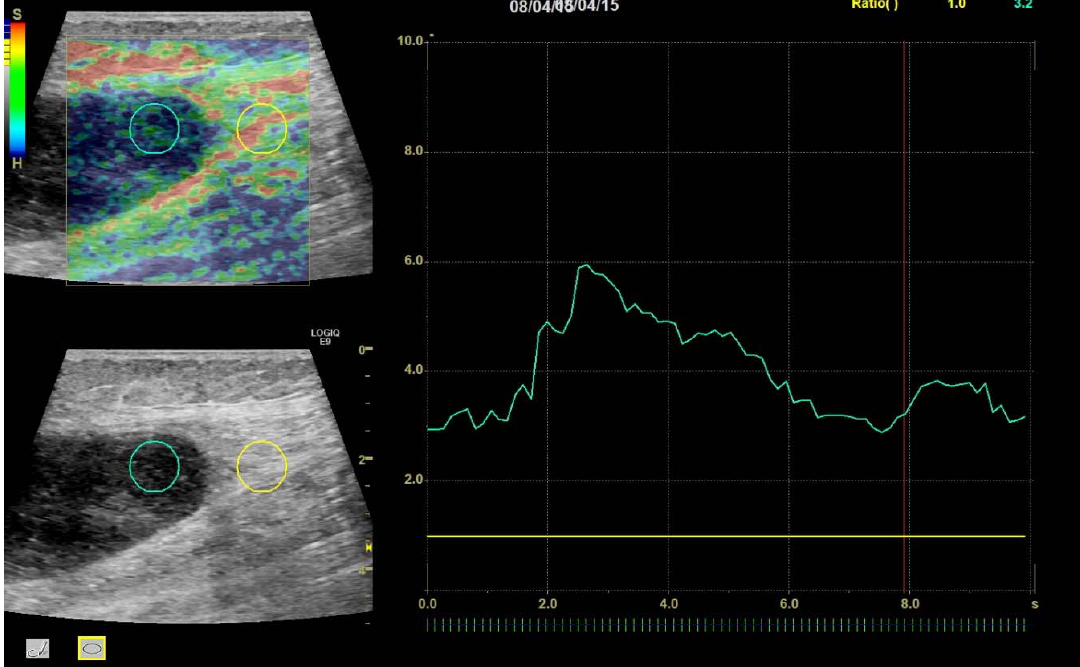
Figure 4. A 96-year-old female with myxoma. Region of interest (ROI) placement in tumor (left circle) and reference tissue (right circle). Tumor scored a TES of 4 and an average SR over the 10 s cine clip of 3.97.